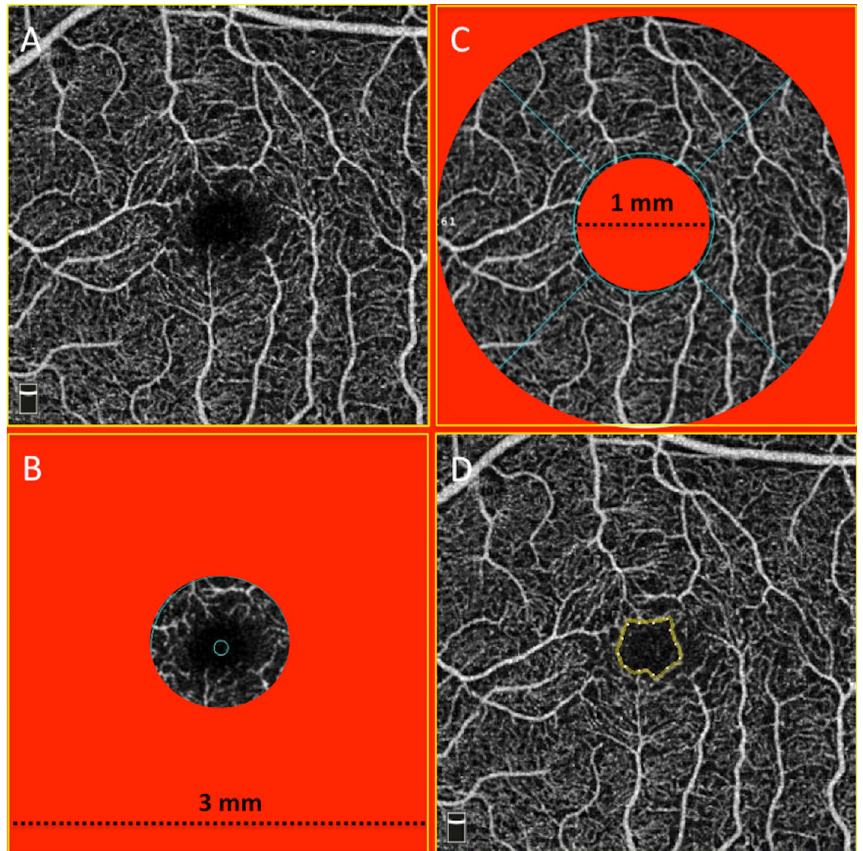
Figure 1. Schematic of optical coherence tomography angiography (OCTA) metrics. ( A ) OCTA image of whole SCP. ( B ) OCTA image of foveal region of the SCP delineated at ring of 1 mm. ( C ) OCTA image of parafoveal region of the SCP delineated between rings of 1 mm and 3 mm, (( D ) OCTA image of full retina with the FAZ outlined in